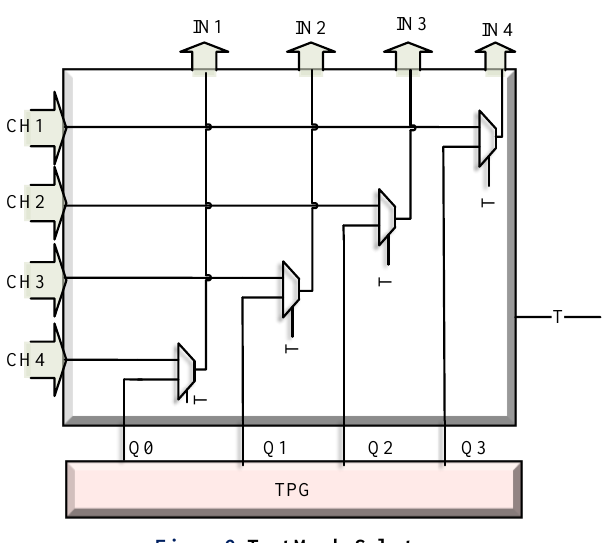
Figure 9. Test Mode Selector.